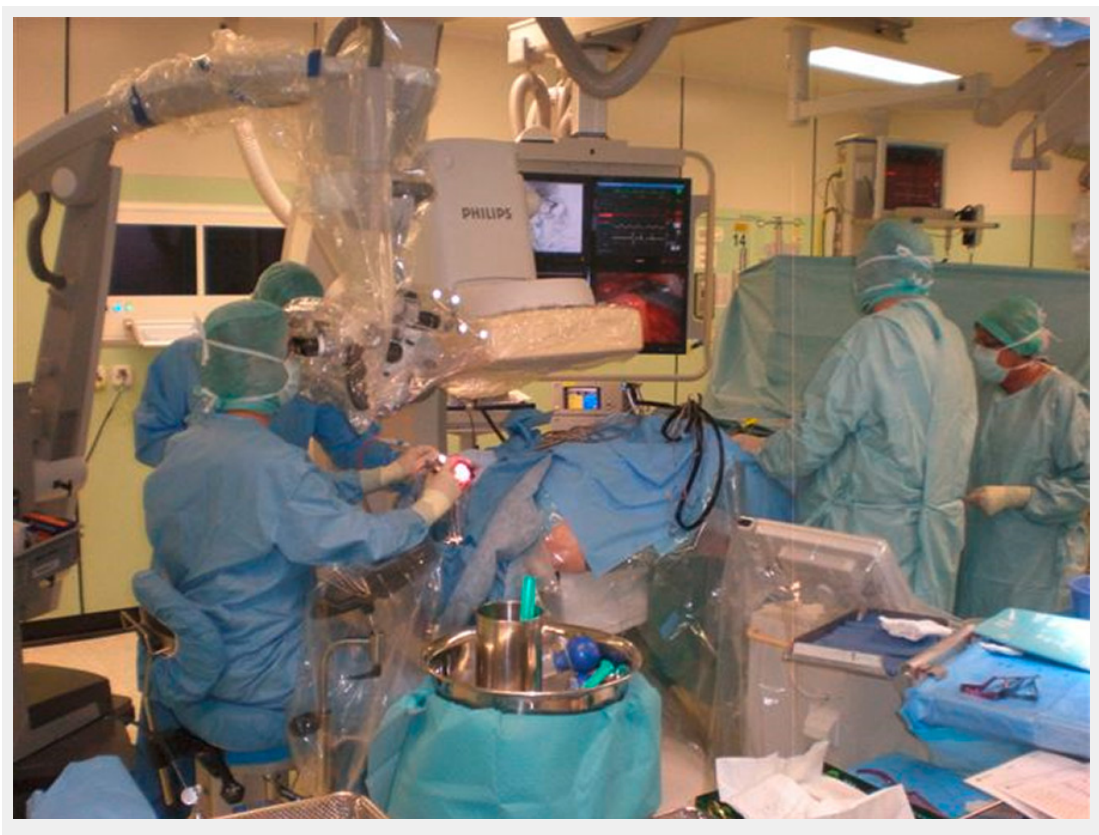
Figure 2 Treatment of an intracranial aneurysm in the hybrid operating room. Combined endovascular and microsurgical techniques for the treatment of intracranial aneurysm in the hybrid operating room (Neurocentre, Kantonsspital Aarau,